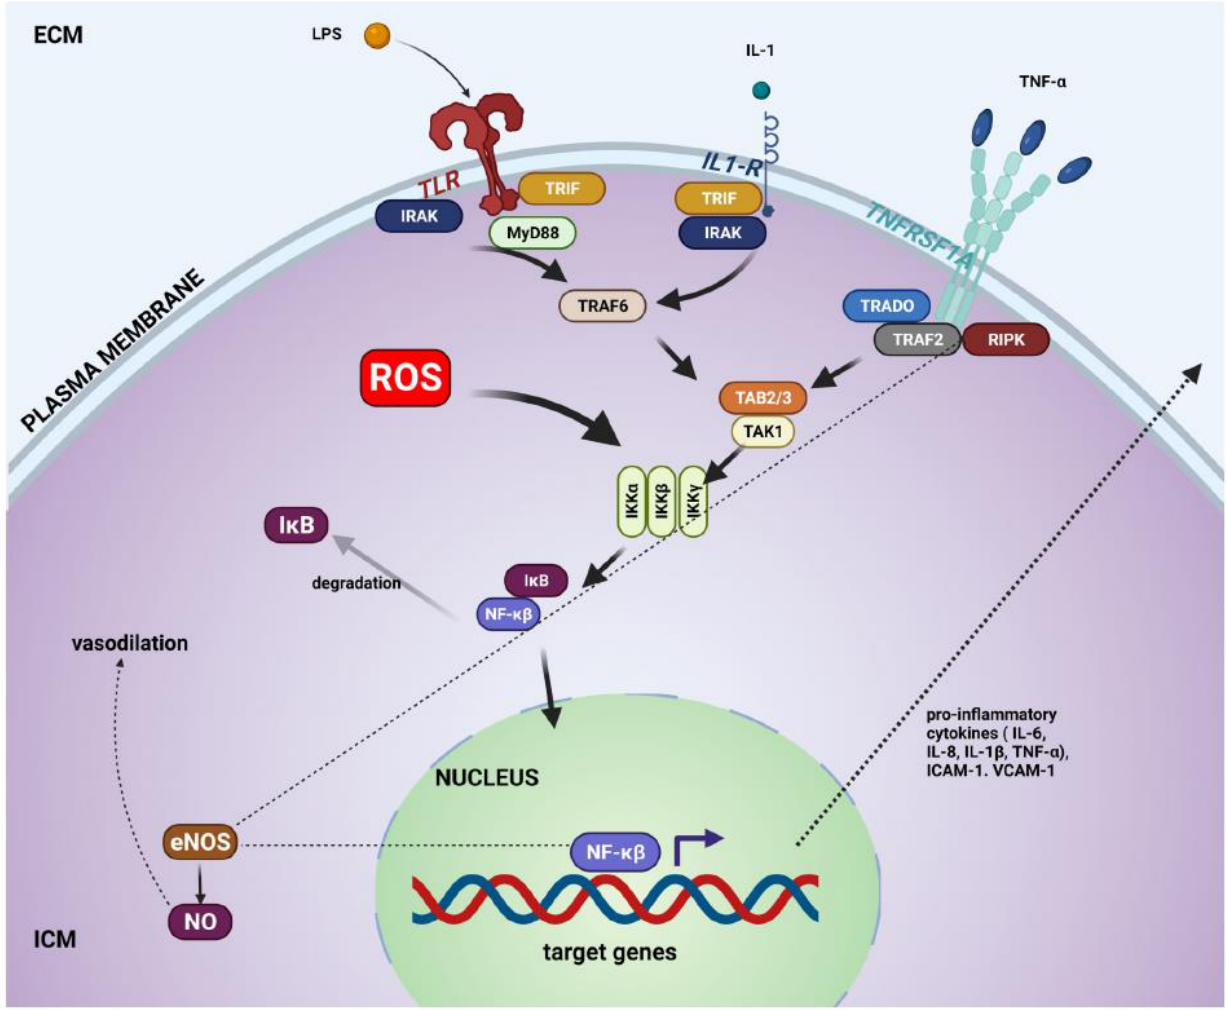
Figure 6. Canonical NF- κB signalling pathway. NF- κB pathway regulates inflammatory responses, apoptosis, and cell growth. Extracellular pro-inflammatory cytokines and bacterial metabolites (LPS) can activate the pathway through appropriate receptors (such as toll-like receptors, IL-1R, and TNFRSF1A) and by an accumulation of intracellular reactive oxygen species (ROS). These stress signals regulate the downstream IKK kinase complex. Activated IKK subunit phosphorylates IkB, which then is ubiquitinated and marked for degradation by proteases. This discharges NF- κB from the IkB-containing complex and uncovers the nuclear localisation signal (NLS). Then, NF- κB com- plex translocases to the nucleus, where it triggers the transcription of target genes that will produce pro-inflammatory cytokines and intracellular adhesion molecules [34,51,52]. Intracellular adhesion molecule-1 (ICAM-1) and vascular cell adhesion molecule (VCAM1) facilitate the infiltration of leu- kocytes from the bloodstream into injured tissue during inflammation [53]. These adhesion mole- cules hold the leukocytes in close proximity to the endothelial cells to allow receptor/ligand inter- actions and facilitate leukocyte diapedesis between endothelial cells [35]. In the cochlea, ICAM-1 is expressed in the basal cells of the stria vascularis, type II and IV fibrocytes of the spiral ligament and endothelial cells of the spiral modiolar vein [35]. As a result, ICAM-1 has a critical role in regu- lating the cochlear immune response by facilitating the extravasation of peripheral leukocytes into the cochlea during inflammation: ECM, extracellular matrix; eNOS, endothelial nitric oxide syn- thase; ICM, intracellular matrix; IRAK, Interleukin-1 receptor-associated kinase; NO, nitric oxide; TRAF, TNF receptor-associated factor; TRADD (TNF-R1-associated death domain protein); TRIF, TIR-domain-containing adapter-inducing interferon- β.